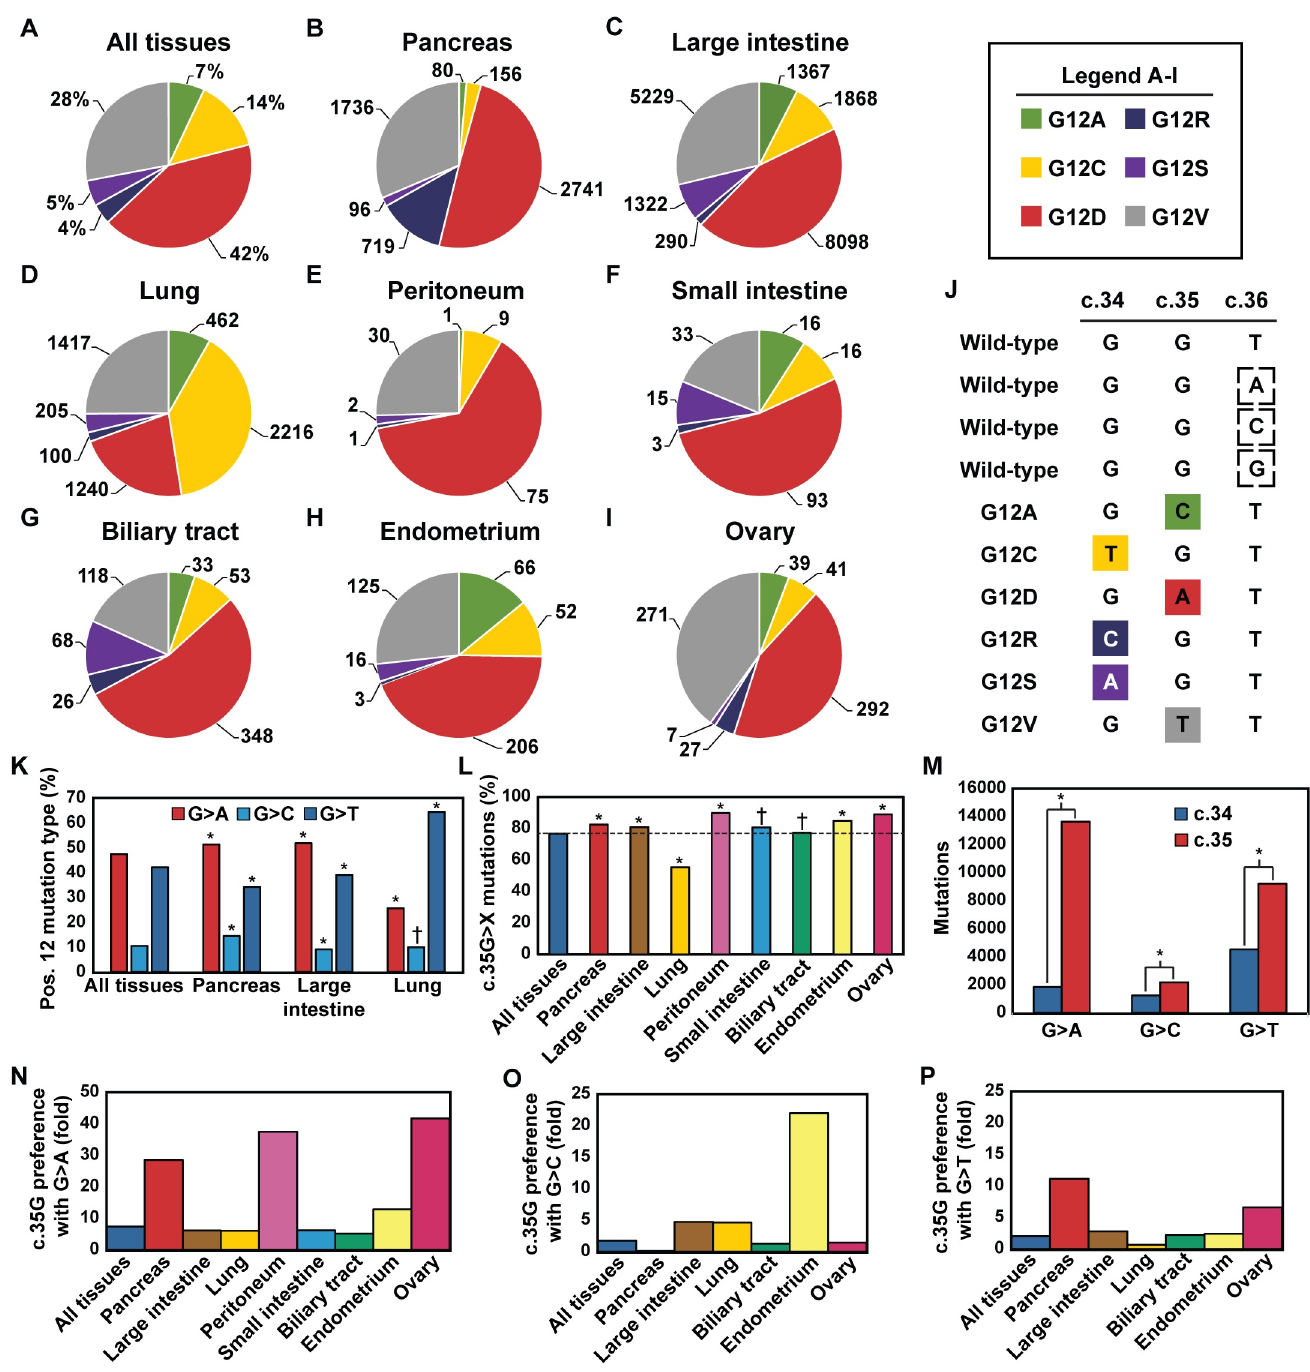
Fig 1. The occurrences of specific KRAS G12X mutations vary among different tissues, and tissues exhibit individual preference in mutation type and position. The occurrence of specific mutations in (A) all tissues, ( B ) the pancreas, ( C ) the large intestine, ( D ) the lung, ( E ) the peritoneum, ( F ) the small intestine, ( G ) the biliary tract, ( H ) the endometrium, and ( I ) the ovary. Numbers shown in panels B-I indicate the numbers of observed positive tumor samples. In panels B-I , the data are ordered from the highest occurrence (%) of a G12X mutation (panel B ) to the lowest (panel I ). Data have been collected from the COSMIC database [2] v.79 (http://cancer.sanger.ac.uk/cosmic/). ( J ) KRAS G12X single point mutations occur if c.34 or c.35 is mutated. ( K ) Mutation types observed in all tissues, the pancreas, the large intestine, and the lung. ( L ) Fraction of position c.35G mutations compared to all the mutations averaged over all tissues, and found in individual tissues. ( M ) Positional mutation preference of specific mutation types in c.34 and c.35. ( N-P ) Position mutation preference characterized through c.35G over c.34G in specific tissues with ( N ) G > A, ( O ) G > C, and ( P ) G > T mutations. Tissues with less than 50 positive samples (the peritoneum, the small intestine) have been omitted from the panels O and P . Statistically significant differences in the panels K - M compared to other tissues or position are indicated with an asterisk, (cid:3) P < 0 . 001 ;† = non-significant (Fischer exact